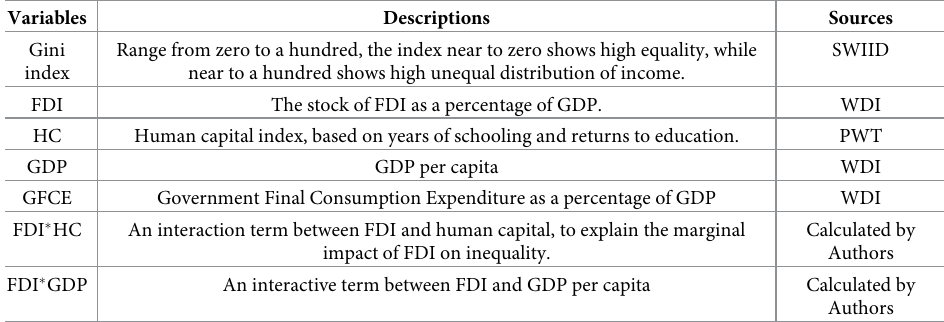
Table 1. Descriptions of the variables and sources of the